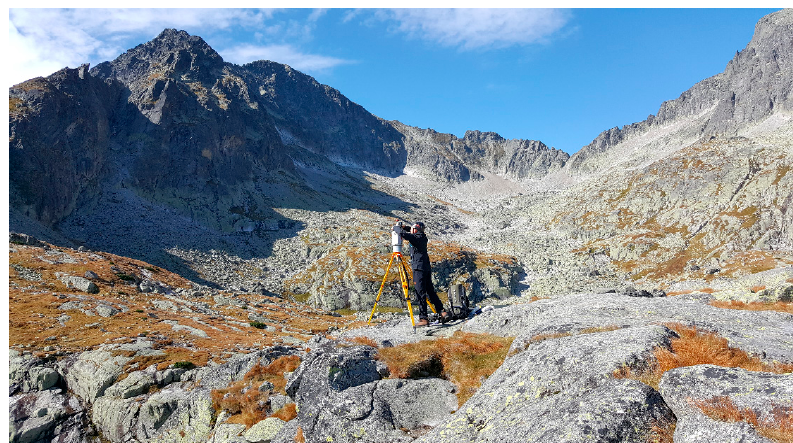
Figure 2. Area of interest viewed towards the headwall of the valley with marked scree thaluses, exposed bedrock and roche moutonees in the bottom of cirques.